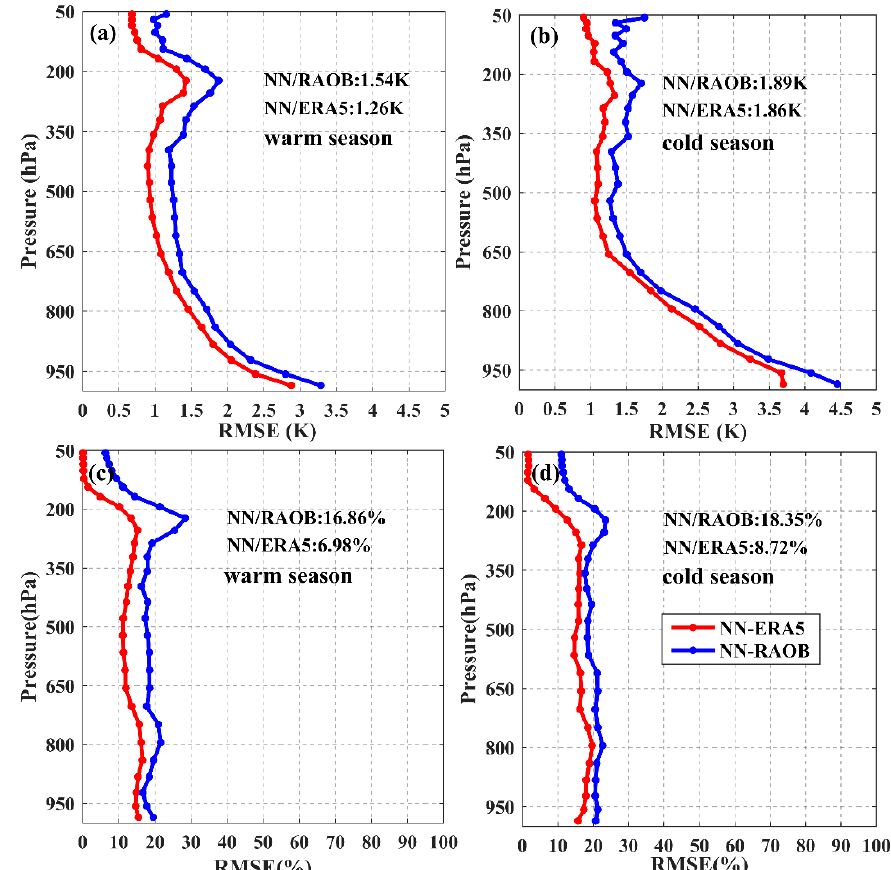
Figure 9. Profile retrieval errors for ( a , b ) temperature, ( c , d ) RH, with respect to RAOBs. The red line represents the RMSE of NNs retrievals versus ERA5 and the blue line represents NNs retrievals versus collocated RAOBs.